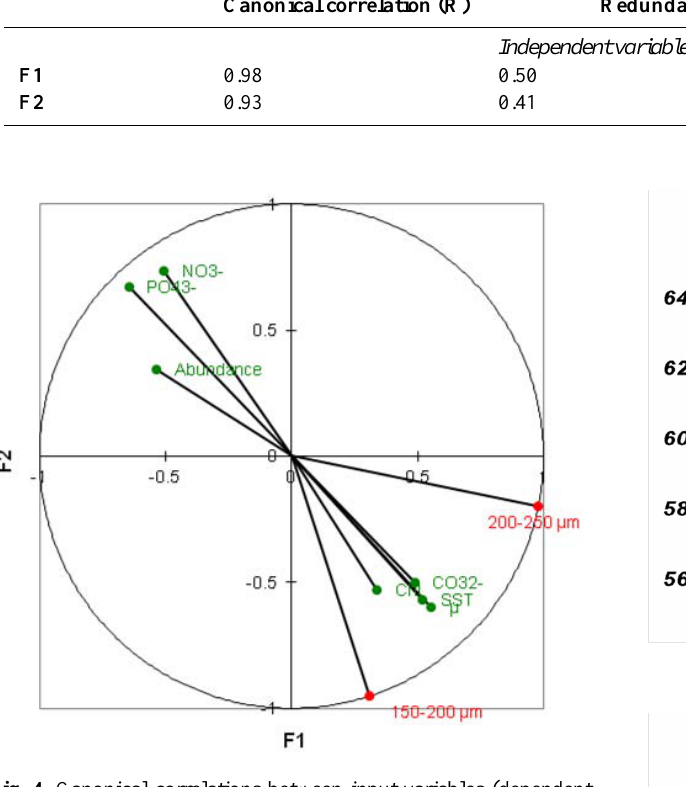
Fig. 4. Canonical correlations between input variables (dependent and independent) and canonical variables (F1 and F2).